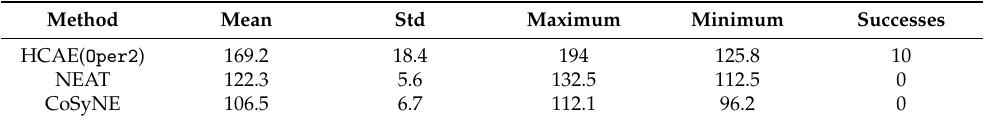
Table 6. Results of experiments on two-spiral problem: average, maximum, and minimum fitness, and the number of runs ended with success.